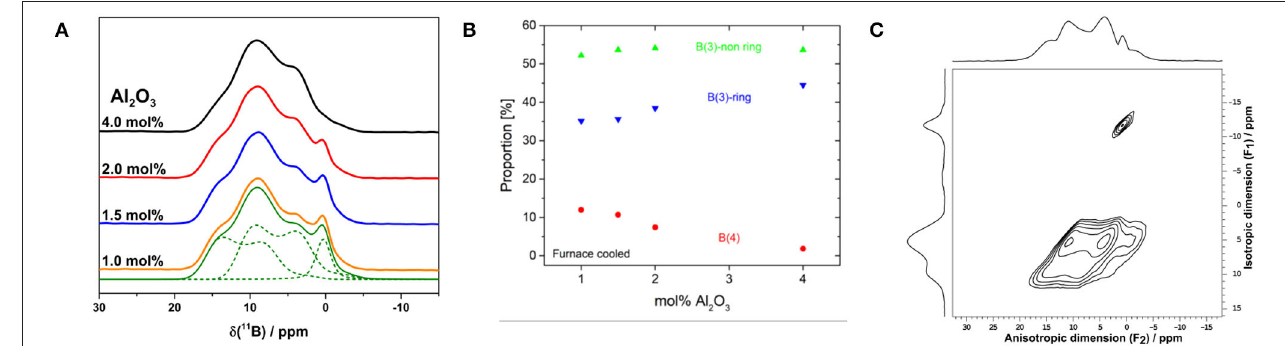
FIGURE 3 | (A) 11 B MAS-NMR at 500 MHz. The figure shows the evolution of three boron bands (two for three-fold coordinated and one for four-fold coordinated boron). Solid lines show the MAS spectra and the dotted lines show a typical deconvolution of 11 B NMR spectra using Multi Quantum MAS. The first dotted line with two peaks ranging from 18 to 5 ppm is assigned to B III ring, the second line from 13 to 2 ppm to B III non-ring and the third dotted line with a Gaussian shape centered at 0 ppm to B IV . (B) The boron ring configuration according to 11 B-MAS NMR results for the furnace cooled glasses. (C) 11 B MQMAS-NMR-Spectra of the sample with 2.0 mol% Al 2 O 3 . Deconvolution of the three spectra in isolated signals.